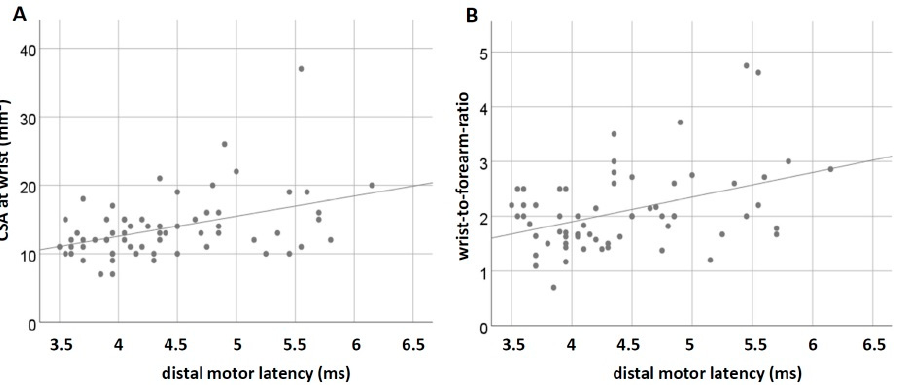
Figure 4. Scatterplots of distal motor latencies and peripheral nerve ultrasound measurements. ( A ) Distal motor latencies and median nerve CSA at the wrist. ( B ) Distal motor latencies and wrist-to- forearm-ratio.